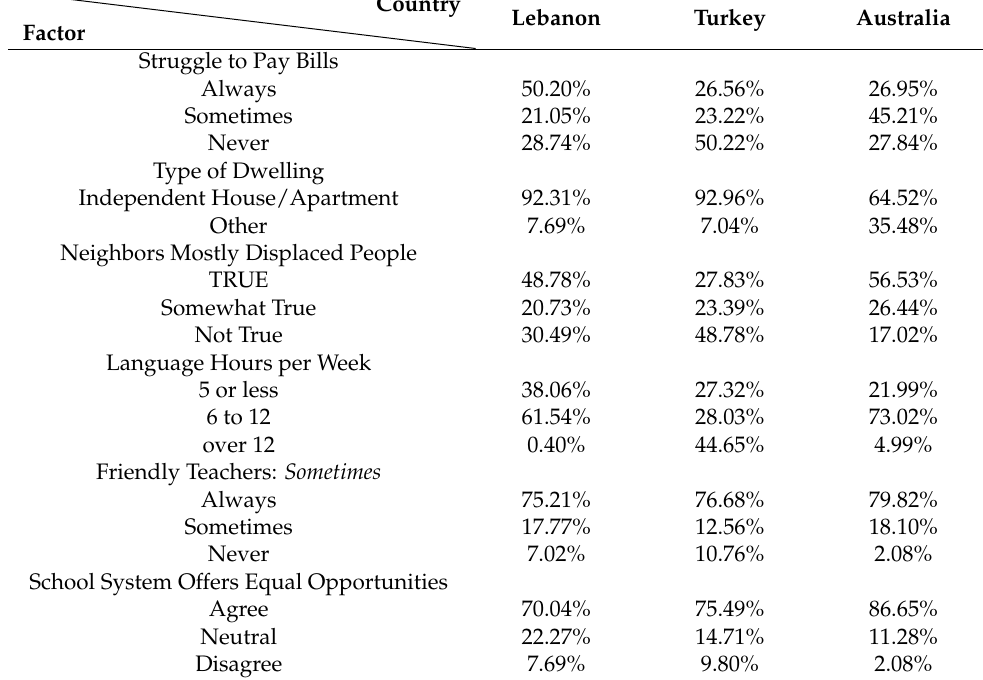
Table 3. Country